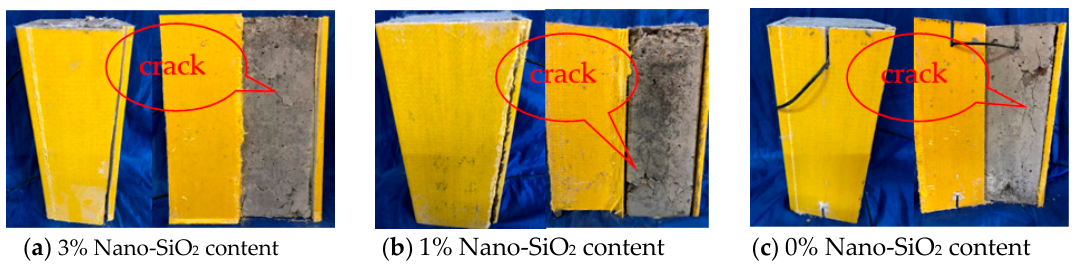
Figure 9. Failure modes of specimens with different nano-SiO 2 contents.